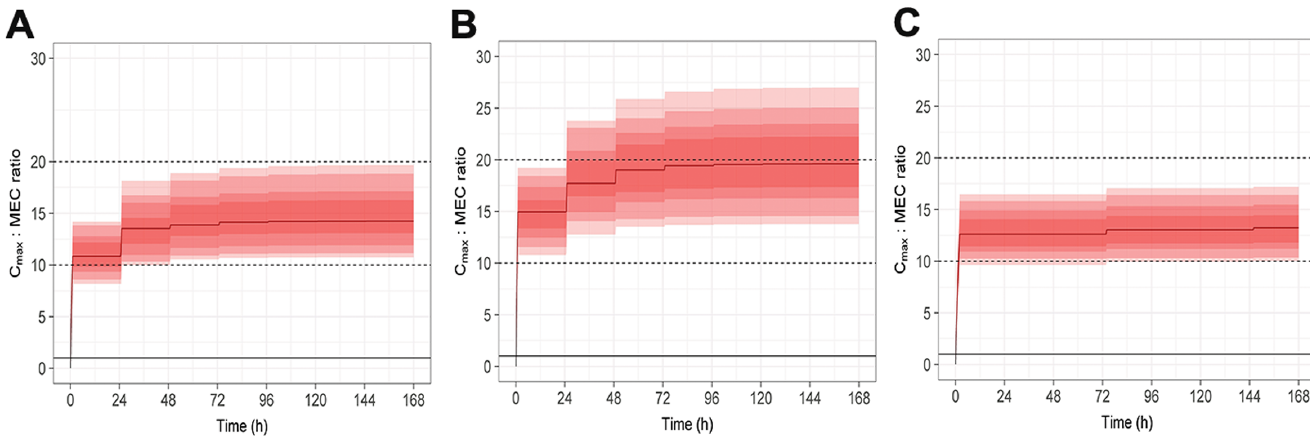
Fig 3. Plots of caspofungin C max :MEC ratio over time. A) 0.75mg/kg dosingdaily for 7 days, B) 1mg/kg daily dosing for 7 days, C) 1mg/kg every 72 hours for 7 days. Red solid line indicatesthe median, shadedribbons show the 95%, 90%, 75% and 50% CI’s in increasinglydark shading. Dashed black lines show the putative upper and lower C max :MEC ratio